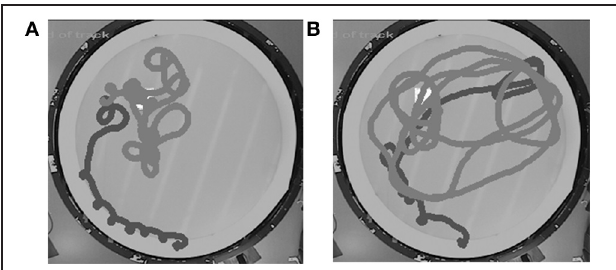
the correct former platform position. As soon as they fail to find the platform, they switch to a wider search pattern, but still show some preference to the original target area (B) . Black trace: first 20s, gray trace: following 40s. The white square indicates the original platform location. Pool diameter